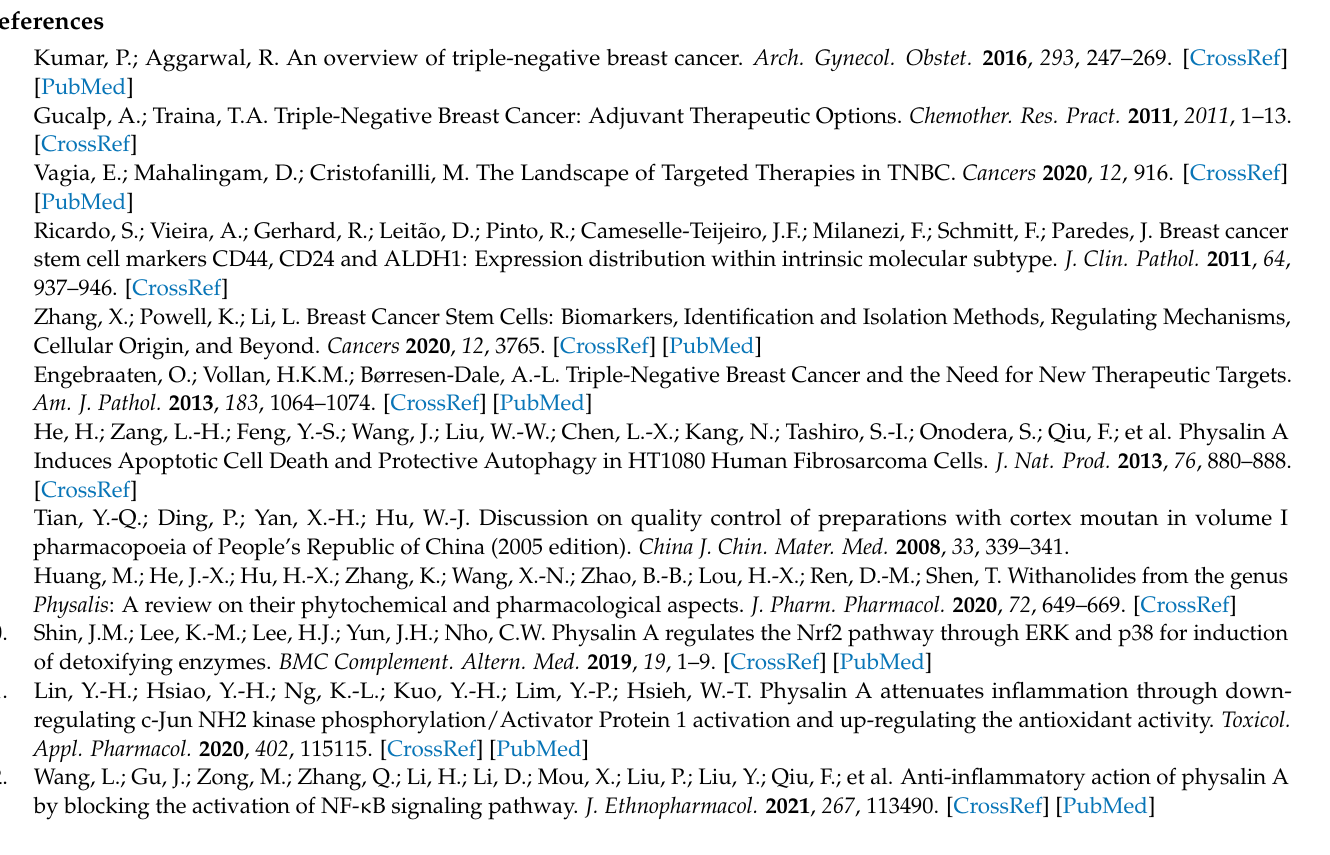
Table S1. Cell viability and mammosphere formation efficiency of another TNBC cell line (HCC-1937) are shown in Figure S1. The western blot data of MCF-7 mammospheres are shown in Figure